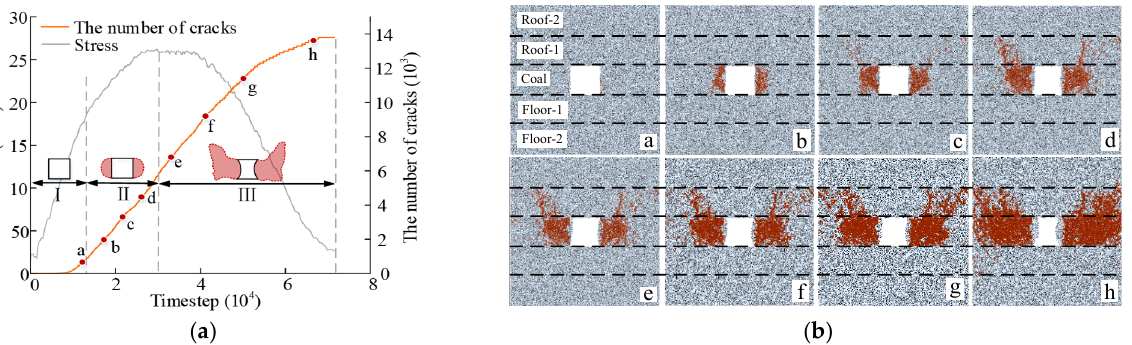
Figure 9. Progressive failure process of roadway surrounding rock. ( a ) The number of cracks evolution curve of roadway surrounding rock. ( b ) Failure process of roadway surrounding rock.